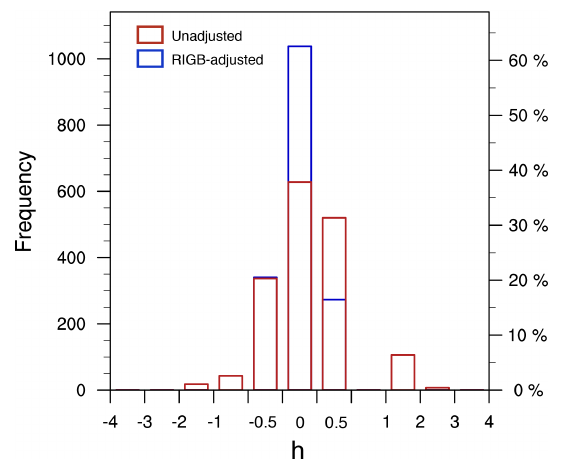
Figure 2. Shifts of maximum insolation time to solar noon in unad- justed data and RIGB adjustment. The bins of solar noon time are non-linear with a minimum of